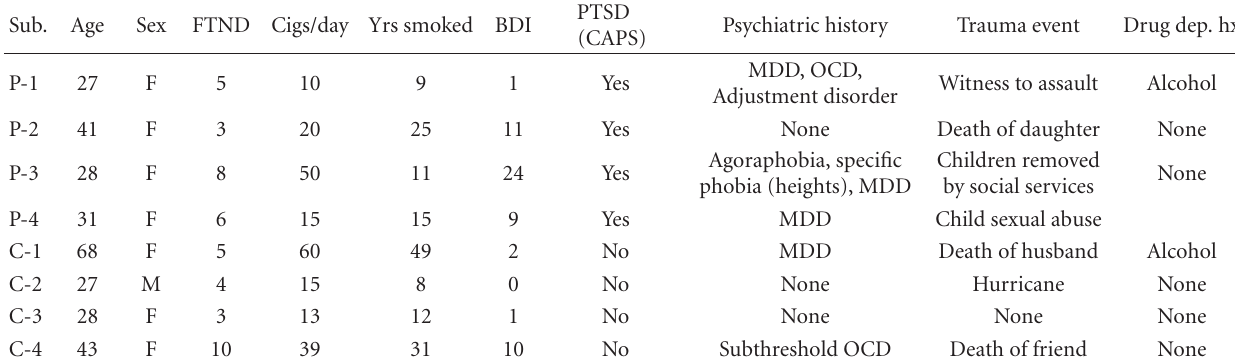
Table 1: Participant demographics ab